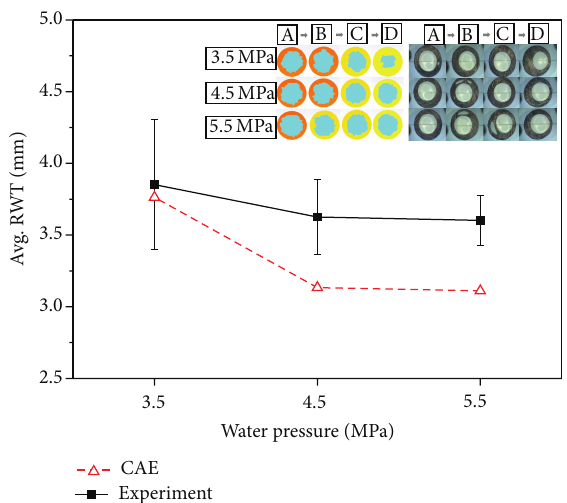
Figure 10: Effect of melt temperature on average residual wall thickness for the experiment and analysis results.